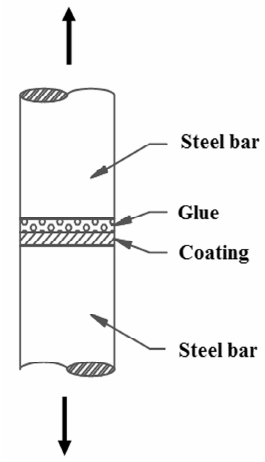
Figure 2. Samples assembled for the bond test and applied tensile load.